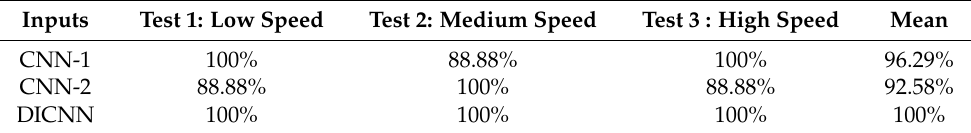
Table 10. Accuracy results of the broken bar classification models. (See speed values in Section 3.3).